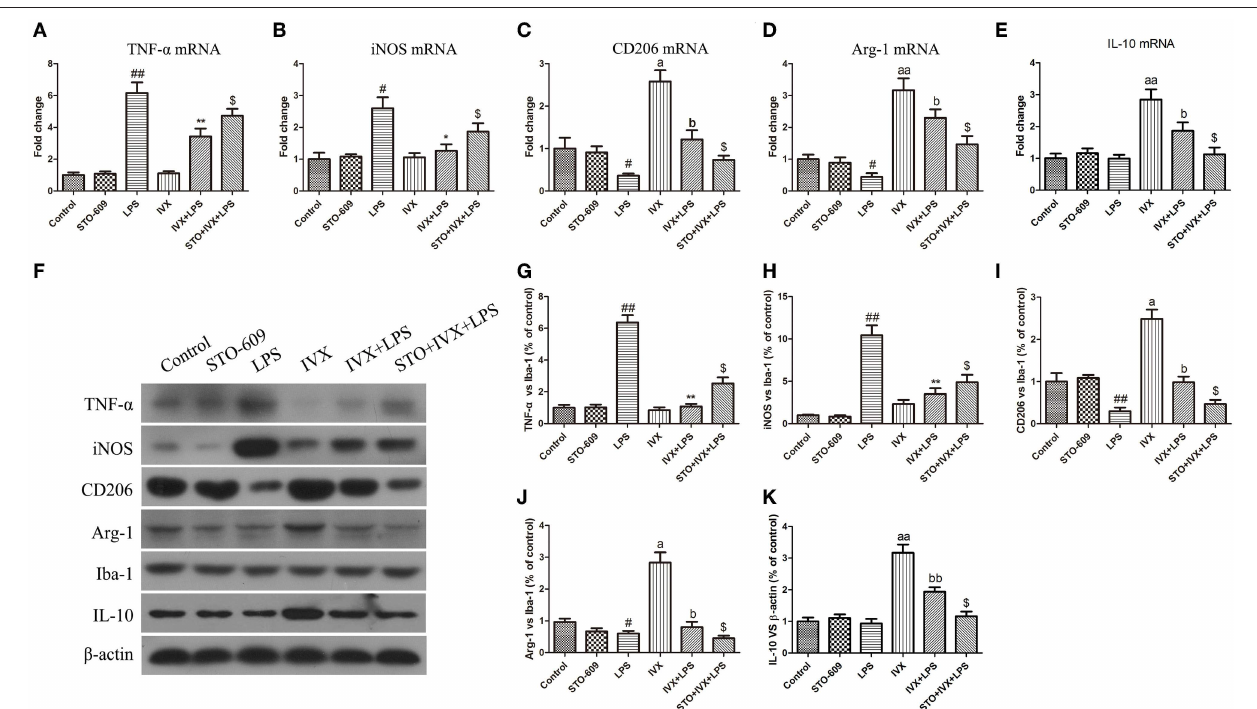
FIGURE 9 | IVX-mediated CaMKK β activation inhibited M1 microglial polarization and promoted M2 microglial polarization in the cerebral cortices of LPS-injected mice. After the open field test, the cerebral cortices of mice were harvested. To investigate the effect of IVX-mediated CaMKK β activation on microglial polarization in LPS-injected mice, the mRNA and protein expression of M1 microglial markers (TNF- α and iNOS) and M2 microglial markers (Arg-1 and CD206) were detected via RT-PCR and western blotting. (A,B) The mRNA expression of M1 microglial markers (TNF- α and iNOS) were measured via RT-PCR. (C,D) The mRNA expression of M2 microglial markers (Arg-1 and CD206) was measured via RT-PCR. (F–H) The protein expression of M1 microglial markers (TNF- α and iNOS) were measured via western blotting. (I,J) The protein expression of M2 microglial markers (Arg-1 and CD206) was measured via western blotting. (E,K) The gene and protein expression of IL-10 was measured via RT-PCR and western blotting. The experiments were conducted in triplicate and repeated at least three times. Values are expressed as mean ± SEM ( n = 4–5 in each group). # p < 0.05 and ## p < 0.01, vs. control group; * p < 0.05 and ** p < 0.01 vs. LPS group; $ p < 0.05 vs. IVX + LPS group; a p < 0.05 and aa p < 0.01, vs. control group; b p < 0.05, bb p < 0.01 vs. IVX